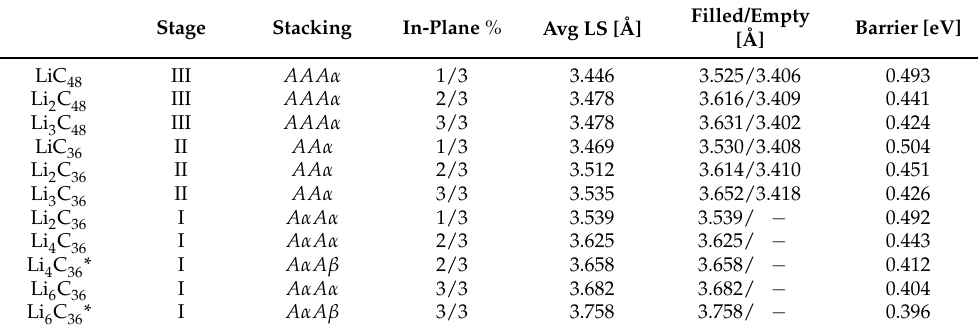
Table 3. Interlayer distances and migration barriers (to the neighboring Li-position), calculated with GPrep-DFTB for a variety of differently stacked, staged, and filled Li-GICs. Regarding the stacking description, A refers to the carbon sheets, whereas α and β refer to the ordering of Li-ions. Filled/Empty Stage Stacking In-Plane % Avg LS [Å] Barrier [eV] [Å] LiC 48 III AAA α 1/3 AAA